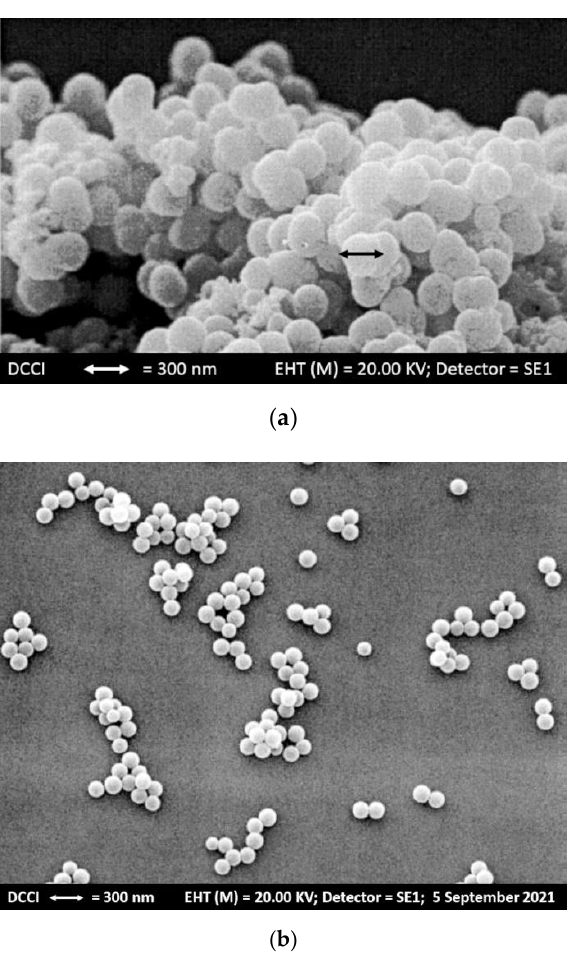
Figure 8. SEM images of G4K ( a ) and BBB4-G4K ( b ) particles.